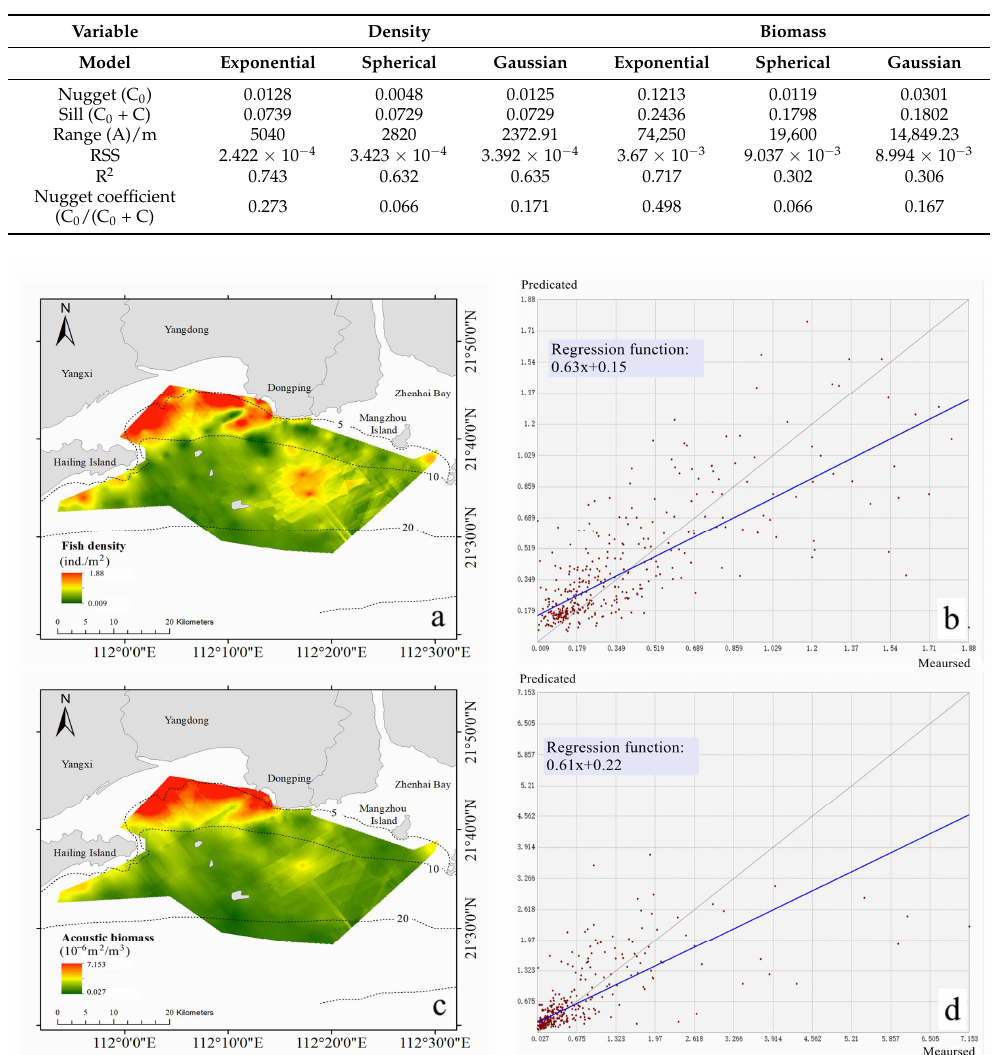
Figure 4. ( a ) Geostatistical interpolation result (density), ( b ) cross-validation (density), ( c ) geostatis- tical interpolation result (biomass), ( d ) cross-validation (biomass).